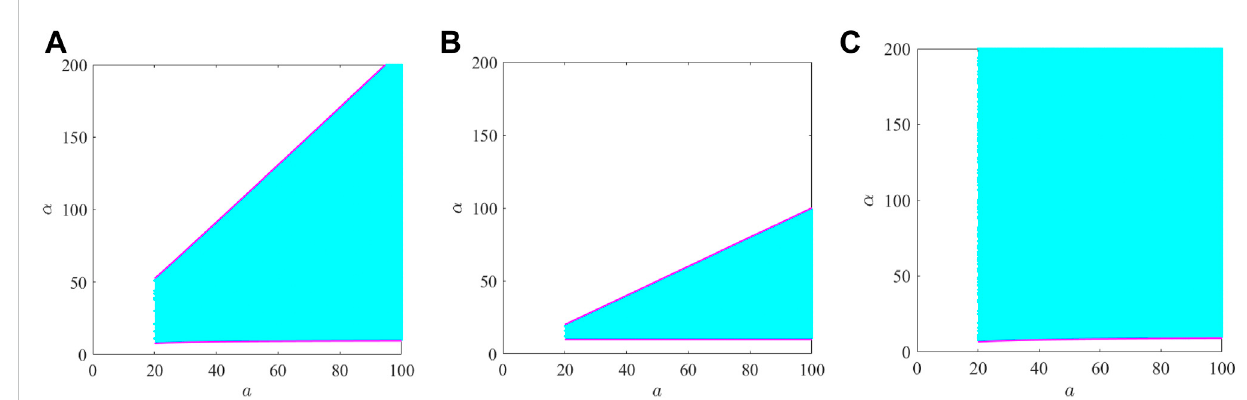
FIGURE 1 Synchronized regions of the Lü system with varying dynamics parameter a and its boundary curves.